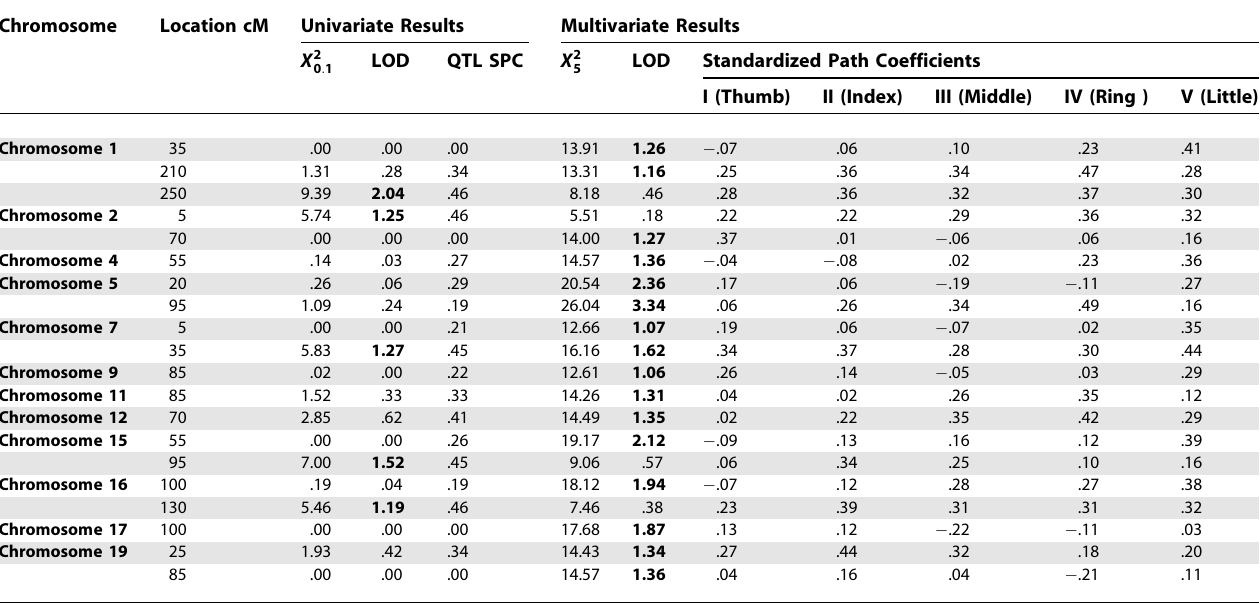
Table 1. Linkage Regions Yielding LOD Scores over 1 (Bold), Change in Minus Twice Log-Likelihood ( (cid:2) 2LL), LOD Scores the Standardized Path Coefficients (SPC) from the QTL Factors of the Univariate and Multivariate Genome Scans